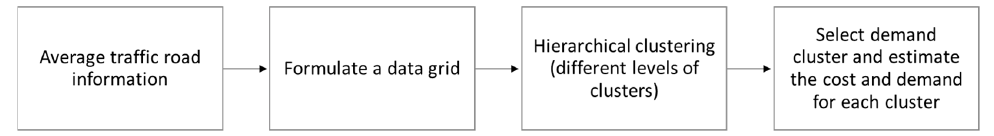
Figure 18. Overview of demand estimation based on charging station clustering [79].